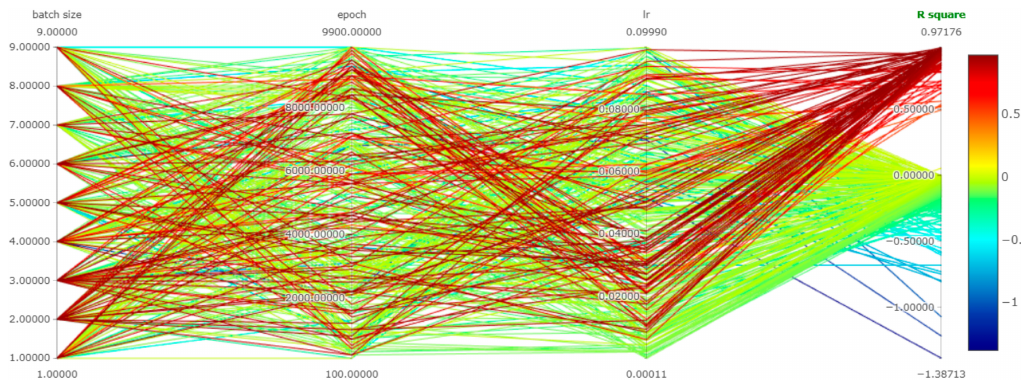
Figure 9. Hyperparameter tuning results. Table 6. The optimized learning